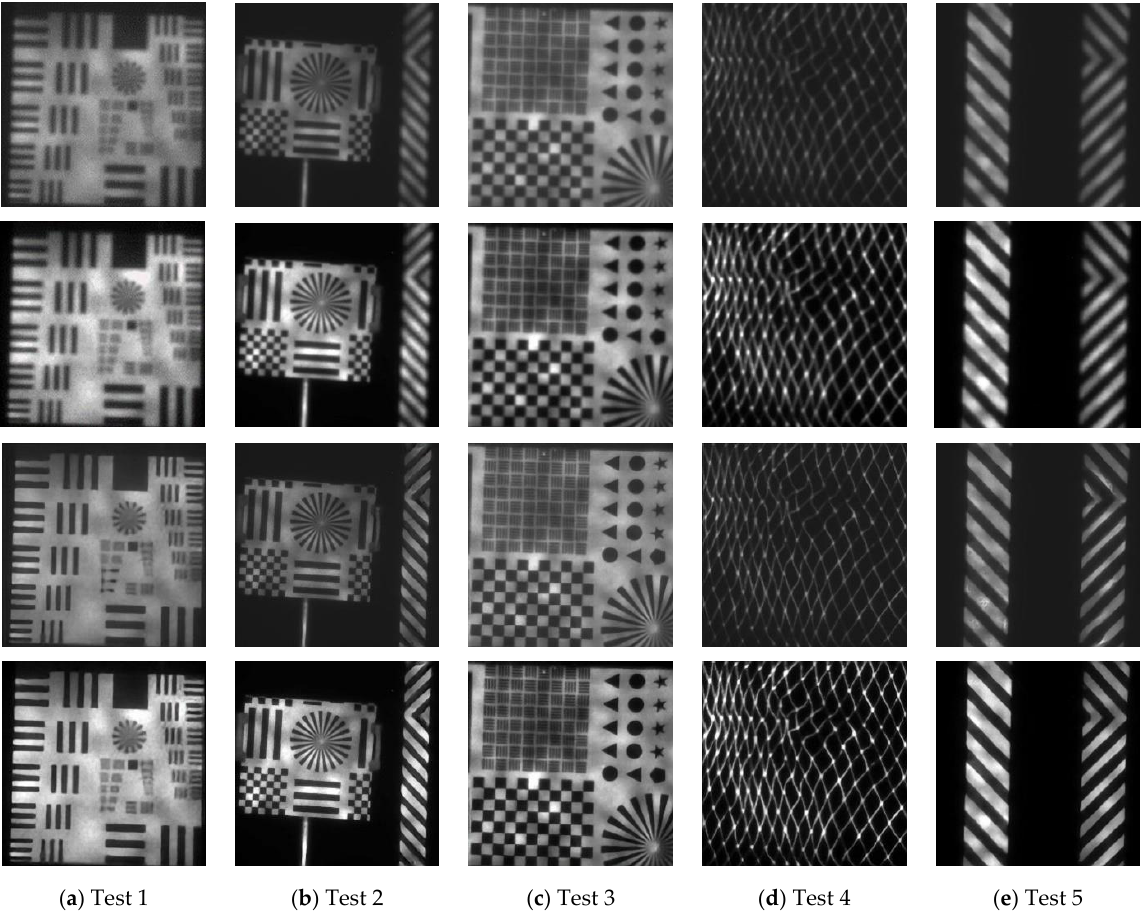
Figure 8. Image deblurring result of the test set. The first row is the original data (denoted by ORI), the second row is the data with the removal of backscattered light (denoted by SUB), the third row is the result of the deblurring of the first row images (denoted by ORI-deblur), and the fourth row is the blur removal result for the second row images (denoted by